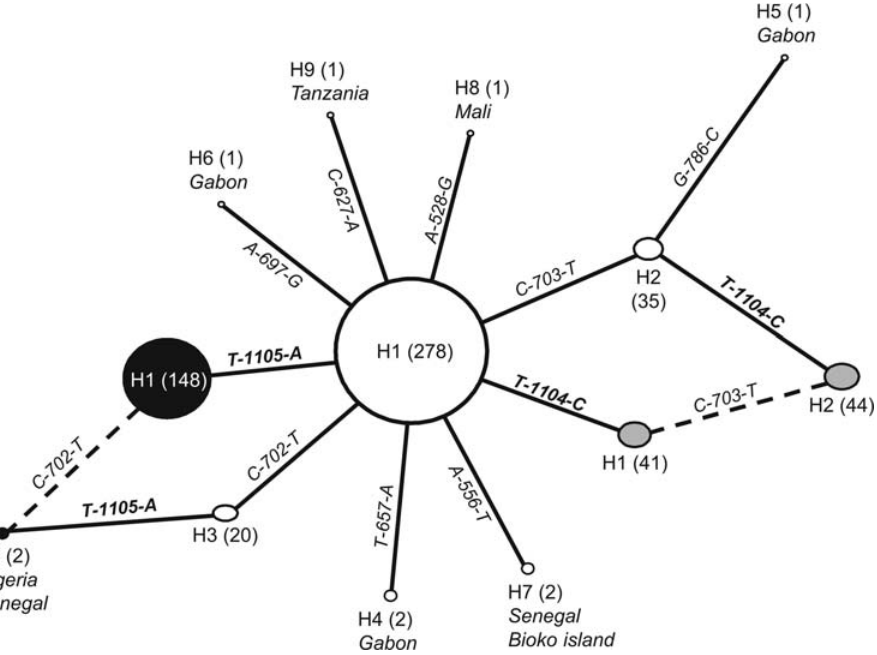
Figure 2. TCS network showing the genealogical relations among kdrhaplotypes of A.gambiae. Each haplotype is represented by a circle with a size proportional to its frequency in the sample (in parenthesis, 2 N =576). Countries where the most rare haplotypes ( i.e. frequency , 0.5%) were found are also reported. Mutational steps are represented by lines with the indication of the mutation from the immediate ancestral haplotype ( kdr mutations in bold). Dashed lines represent reticulation ambiguities (see Discussion). White circles: haplotypes carrying the wild-type 1014L allele. Gray circles: haplotypes carrying the 1014S allele at the kdr locus (T-1104-C). Black circles: haplotypes carrying the 1014F allele at the kdr locus (A-1105-T).